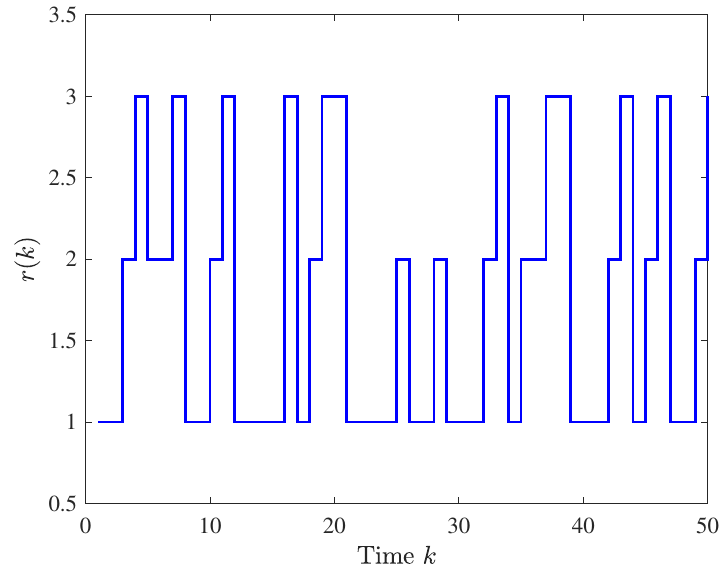
Figure 2. Evolution of r ( k ) in Case